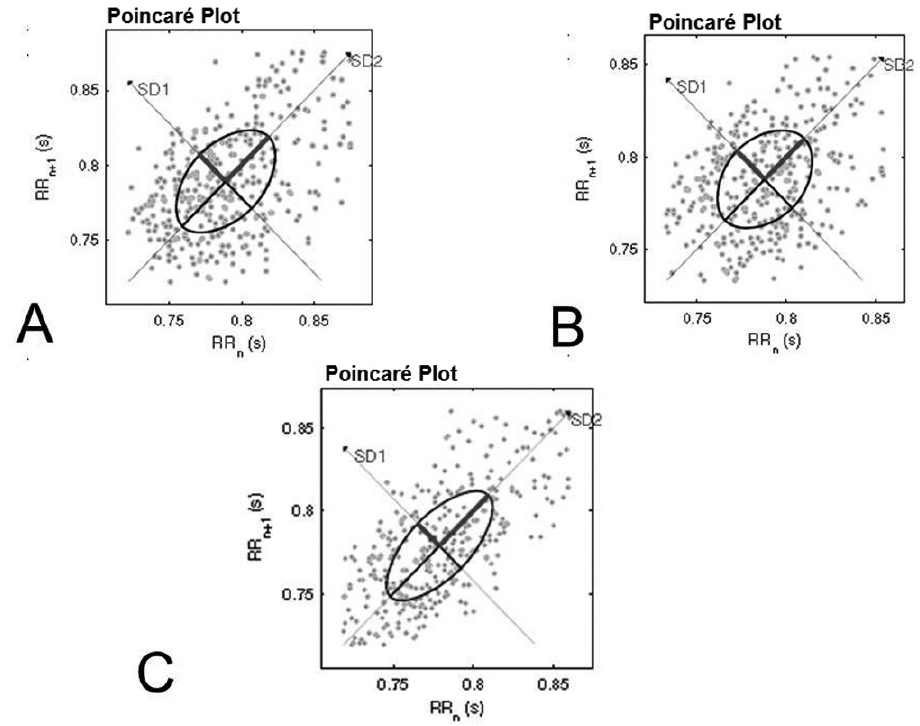
Figure 3 - Visual pattern of the Poincare´ plot observed in one subject during the control condition (A), exposure to relaxant baroque music (B) and exposure to excitatory heavy metal music